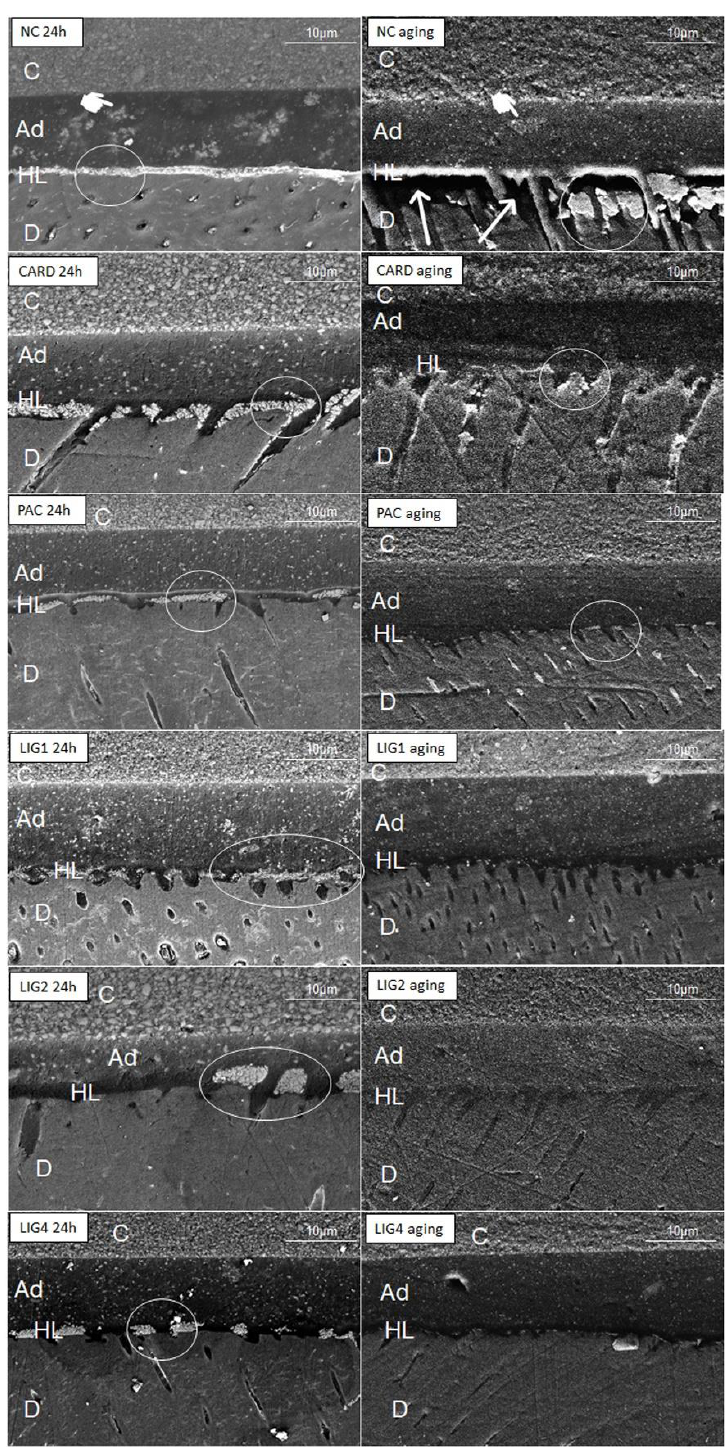
Figure 2. SEM images of the bonded interface of resin-dentin specimens assayed 24 h and after thermocycling aging. The pointers depict water-trees into the adhesive layer, arrows represent a fracture, and circles highlight silver infiltration into the hybrid layer. NC: Negative Control; CARD: Cardanol; PAC: Proanthocyanidin; LIG: Lignin; C: composite layer; Ad: adhesive layer; HL: hybrid layer; D, dentin. NC showed water-trees and striking silver uptake both in both 24 h and after aging. CARD and PAC showed areas of silver uptake both in 24 h and after aging. Water-trees were found only with PAC after aging. LIG1, LIG2 and LIG4 showed similar areas of silver uptake in HL but very little nanoleakage after aging .